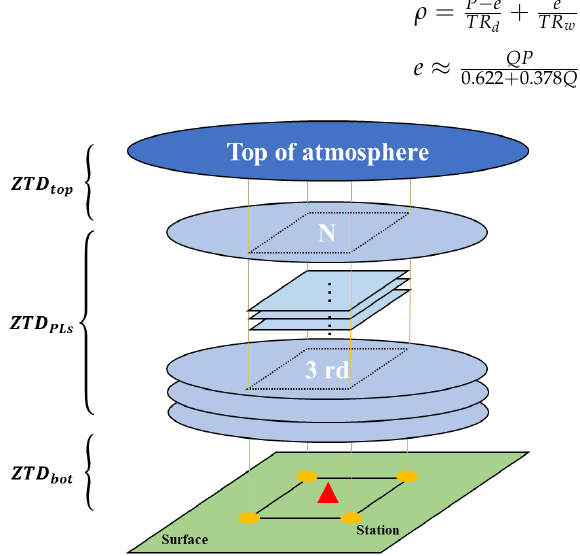
Figure 3. Schematic diagram of the ZTD integration method for reanalysis